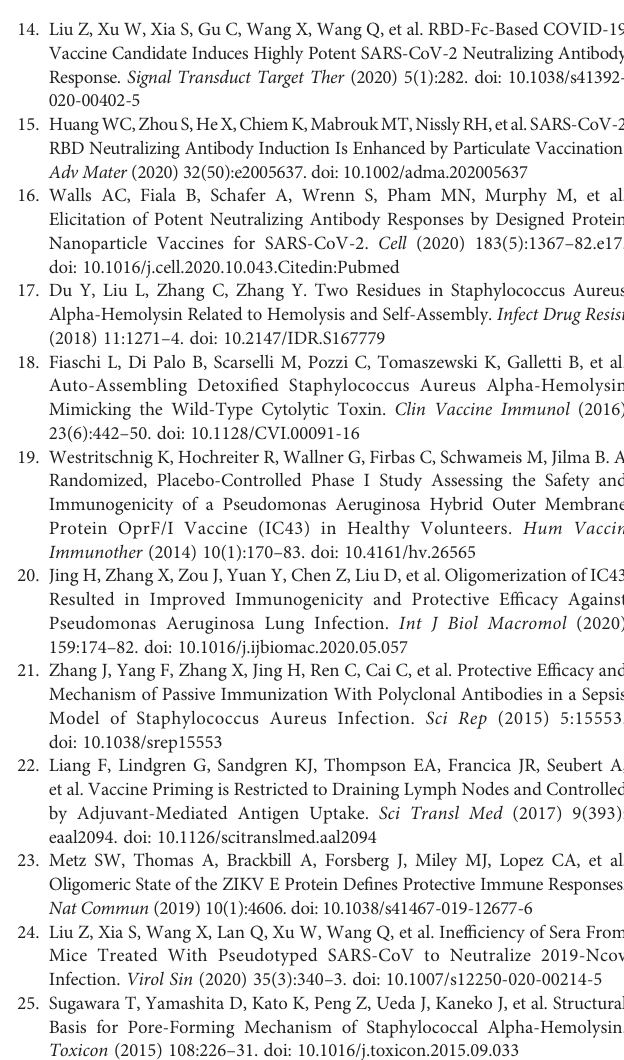
Supplementary Figure 1 | Determine of the titers of anti-mHla antibodies. One week after the third immunization (day 35), mHla-speci fi c immunoglobulin gamma (IgG) antibody titers (A) and different dilutions of IgG (B) were detected by ELISA. One-way ANOVA with Tukey ’ s multiple comparisons, **** p < 0.0001. Supplementary Figure 2 | Hemolytic activity assay. Hemolysis activity was determined by measuring hemoglobin release of rabbit erythrocytes treated with indicated concentration of wild type Hla, mHla-RBD, 1% Triton X-100 and PBS was used as positive and negative control. Supplementary Figure 3 | Oligomeric state of RBD determined by size-elution chromatography. Supplementary Figure 4 | Presentative images of alpha-variant pseudovirus infection blocked by serial dilution of sera from immunized Balb/c mice. Supplementary Figure 5 | Presentative images of beta-variant pseudovirus infection blocked by serial dilution of sera from immunized Balb/c mice. Supplementary Figure 6 | Presentative images of gamma-variant pseudovirus infection blocked by serial dilution of sera from immunized Balb/c